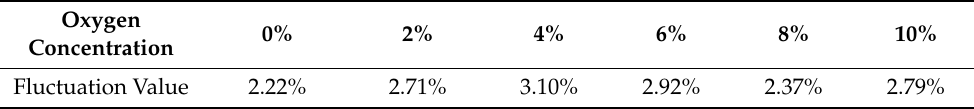
Table 1. Energy Fluctuation Values of the Model at Different Oxygen Concentrations.